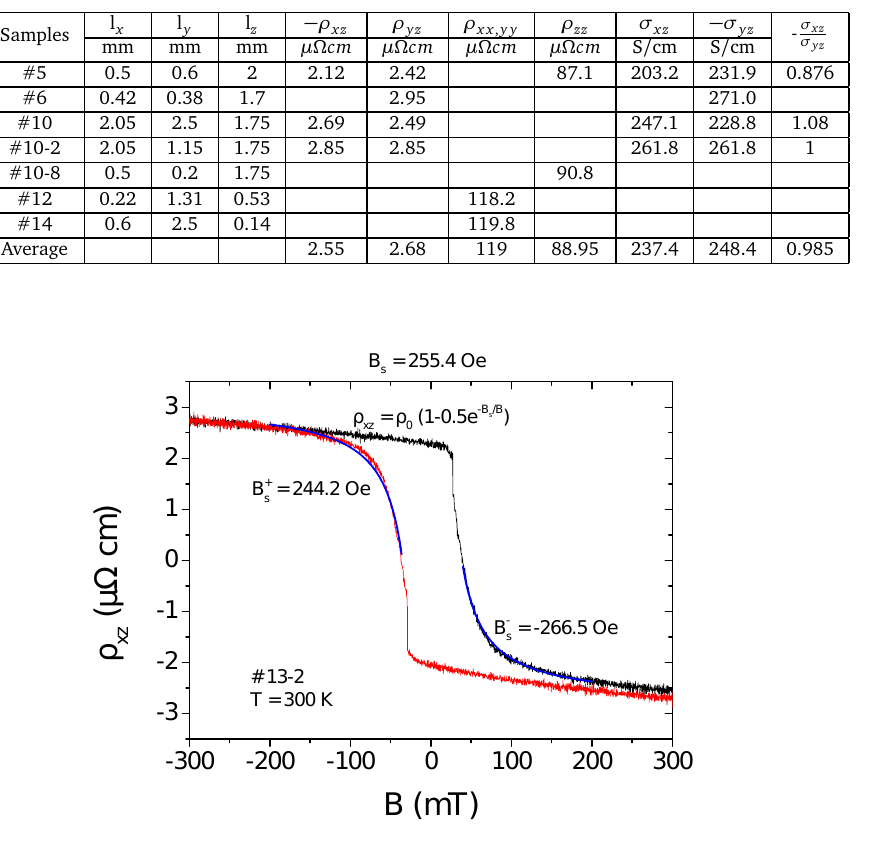
in the sample # 13-2 at 300 K s Sn (at 50K) with MnSi (at 3